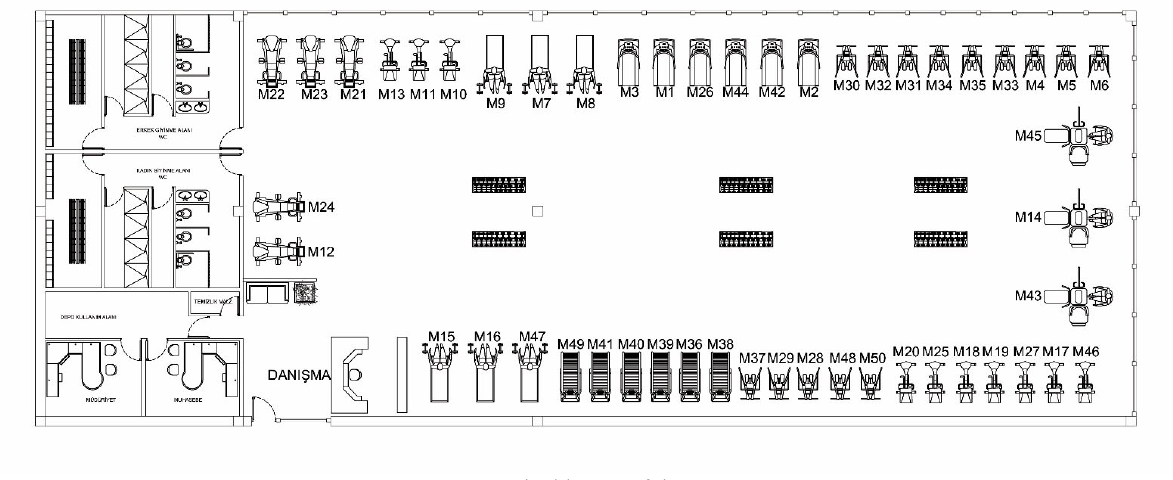
Fig. 2. Final layout of the